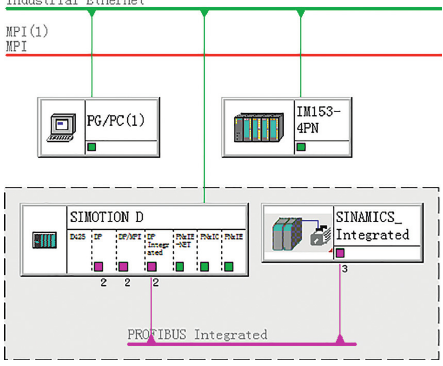
Figure 11: Testing machine hardware configuration. Table 2: Machine working shaft process object configuration. Table 3: Slip control verification test scheme.